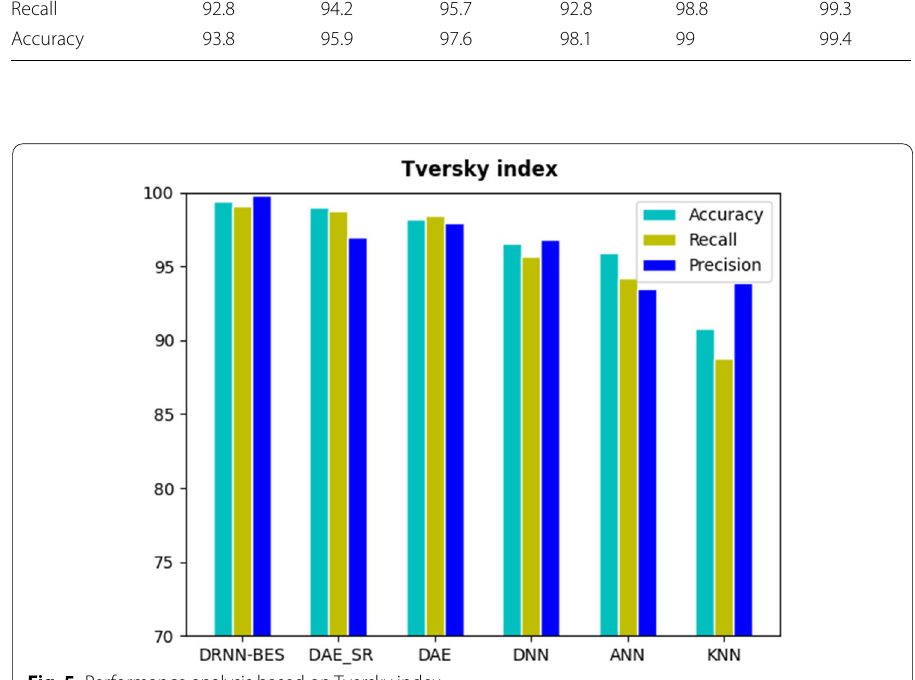
Fig. 5 Performance analysis based on Tversky index